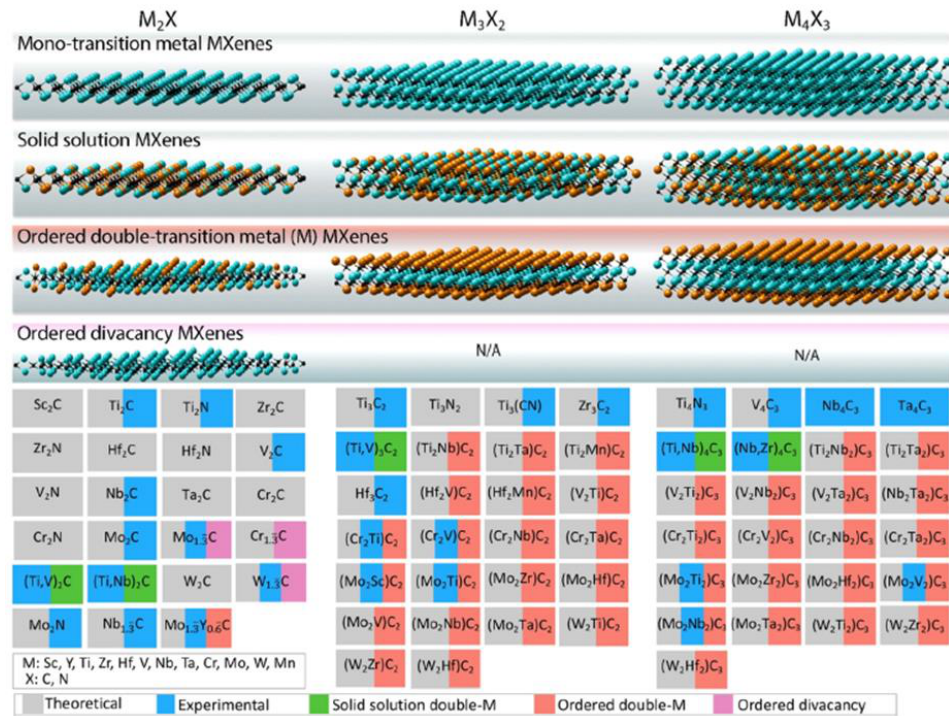
Figure 5. MXenes synthesized up to date. The top row illustrates structures of (top–down) mono − M MXenes, double-M solid solutions (SS) (marked in green), ordered double-M MXenes (marked in red), and ordered divacancy structure (only for the M 2 C MXenes), respectively. This table shows the MXene reported both experimentally (blue) and theoretically (gray) so far [32] Copyright American Chemical Society,